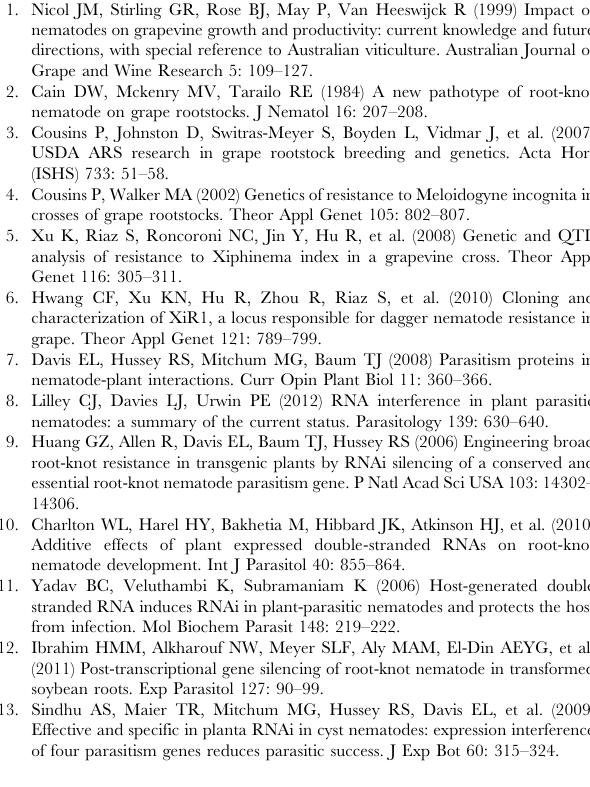
Table S2 The top 51–100 small RNAs from four pART27- 42 transgenic hairy root lines. Table S3 Relative expression levels of the 16D10 gene, determined by Q-RT-PCR, in four pART27-271 and seven pART27-42 transgenic hairy root lines. Table S4 The small RNAs recovered from pART27-27 1hairy root lines.